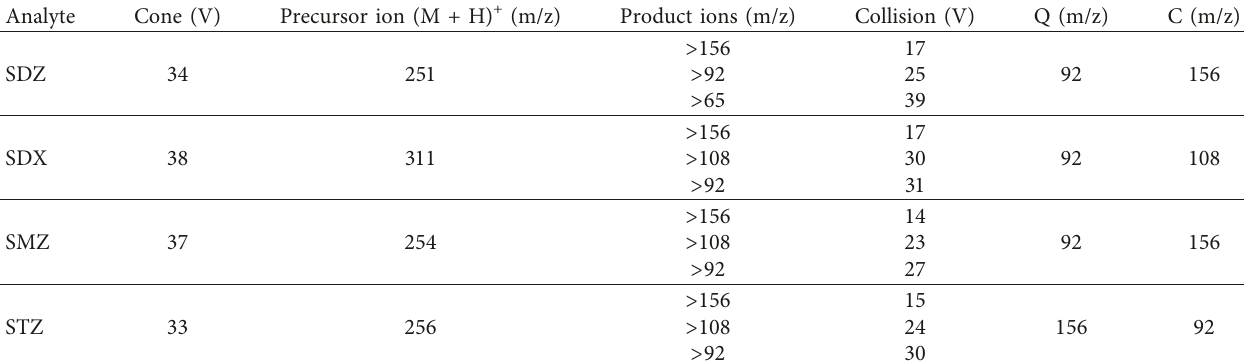
Table 2: Setting values for mass detection and parameter values multiple reaction monitoring (MRM). Analyte